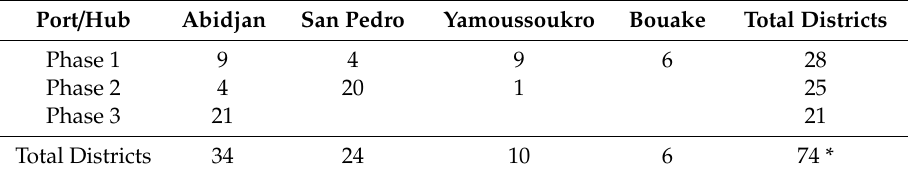
Table 2. Number of districts supplied / served by CIV ports and / or